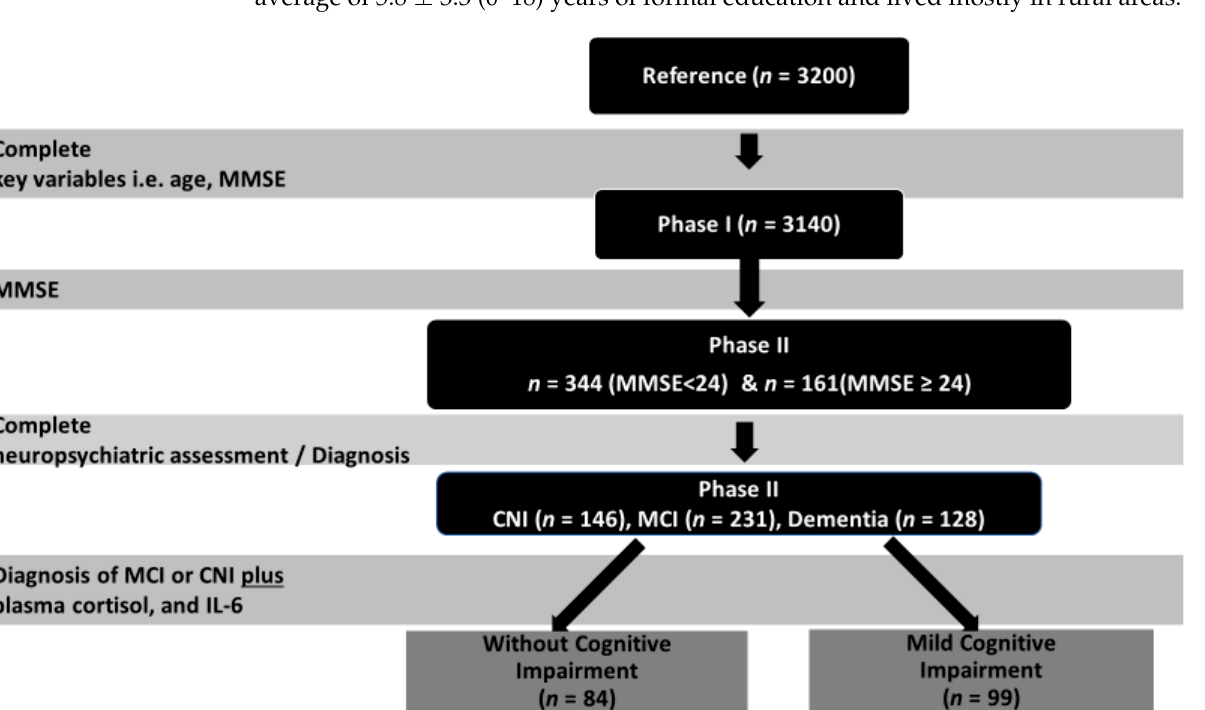
Figure 1. Study flowchart. MCI, mild cognitive impairment; CNI, without cognitive impairment; MMSE, Mini Mental State Examination.